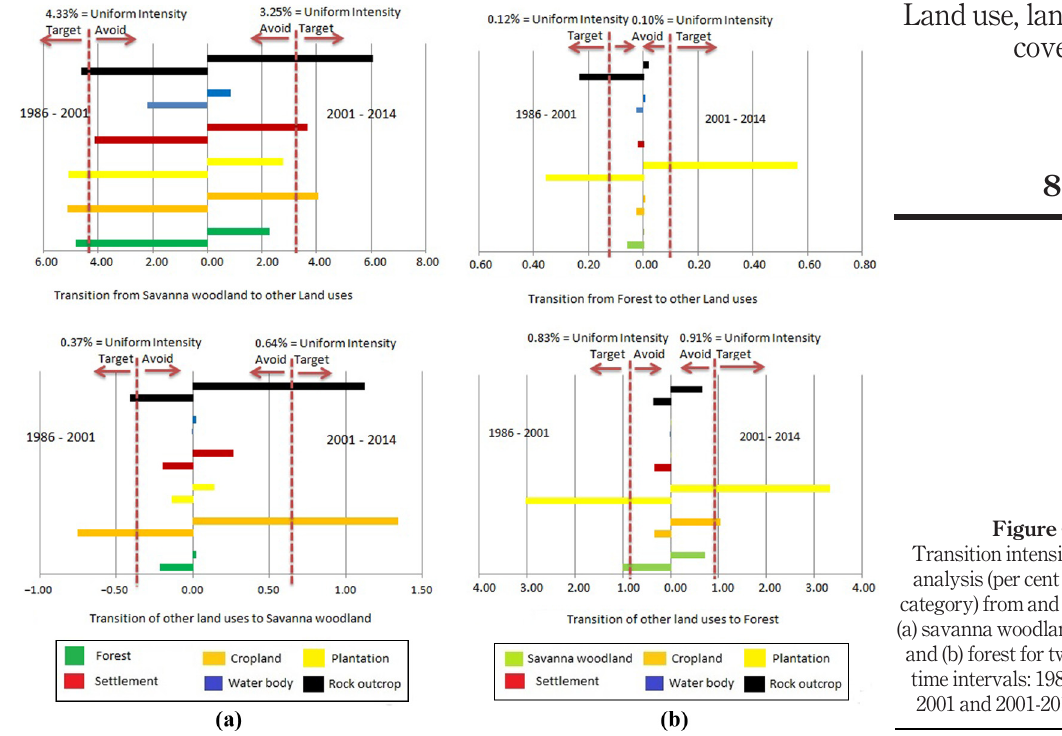
Figure 6. Transition intensity analysis (per cent of category) from and to (a) savanna